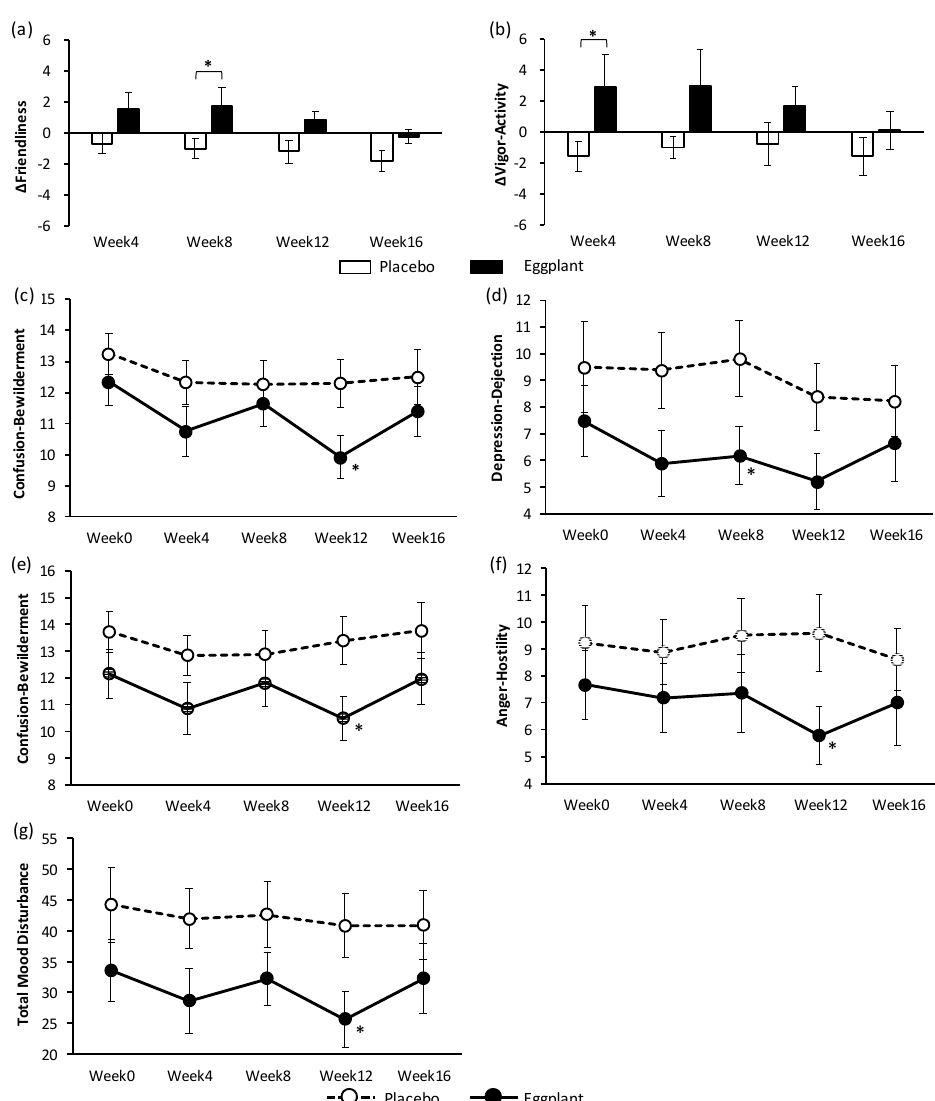
Figure 4. Changes in POMS-2 scores (different values from week 0: ( a ) and ( b ); measured values: ( c ), ( d ), ( e ), ( f ), and ( g )). ( a ) Friendliness and ( b ) vigor-activity of participants with grade 1 hypertension. ( c ) Confusion-Bewilderment scores of all participants. ( d ) Depression-dejection, ( e ) confusion-bewilderment, ( f ) anger-hostility, and ( g ) total mood disturbance in participants with normal-high BP. * p < 0.05 vs. placebo group. Values are presented as mean ± standard error. BP: blood pressure; POMS-2: Profile of Mood States 2nd Edition.